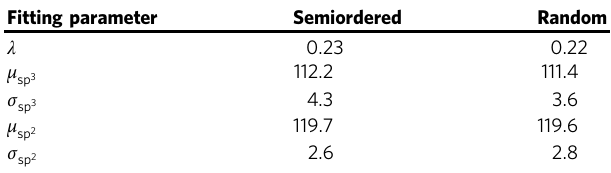
Table 2 Fitting parameters of the the semiordered and the random graphene oxide models, using the two Gaussian functions of Eq. (1).